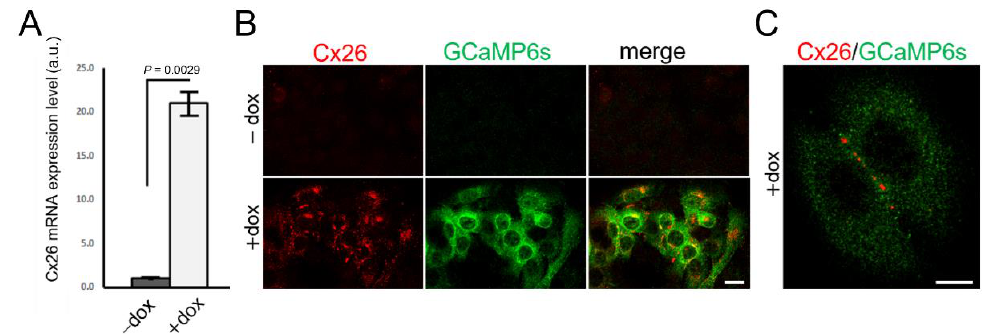
Figure 2. Characterization of Cx26 expression in HaCaT-Cx26-GCaMP6s cell pools. ( A ) qPCR assay of Cx26 mRNA expression levels (mean values ± standard deviation) in HaCaT-Cx26-GCaMP6s cells not exposed ( − dox) or exposed (+dox) to dox (2 µg/mL, 24 h). p -values ( P ) were calculated using a two-tailed t -test. ( B ) Representative confocal images of fixed and permeabilized cells labelled with anti-Cx26 (red) and anti-GFP (green) antibodies (the GFP epitope recognized by the antibody is also present in GCaMP6s); scale bar: 20 µm. ( C ) Higher magnification view showing fluorescent puncta at points of contacts between adjacent cells; scale bar: 10 µm.